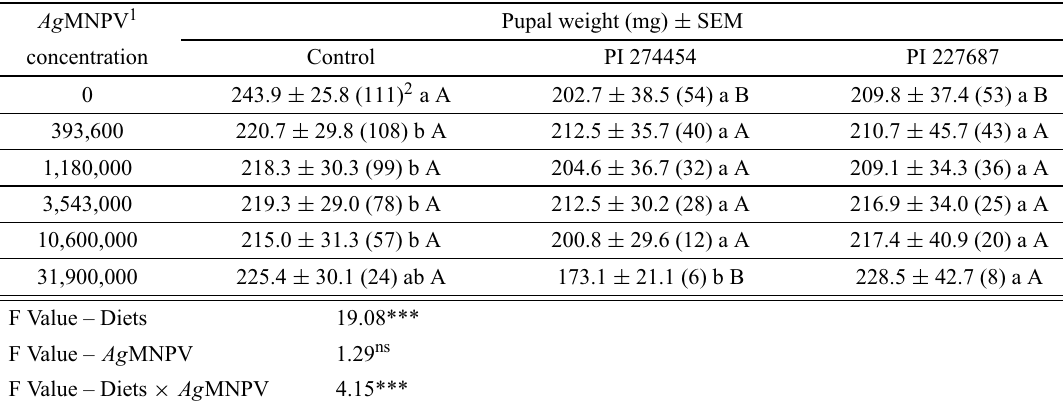
Pupal weights of Anticarsia gemmatalis (R population) fed on diets containing soybean extracts (PI 274454 and PI 227687) and different AgMNPV concentrations with the number of surviving individuals in brackets. Ag MNPV 1 Pupal weight (mg) ± SEM concentration Control PI 274454 PI